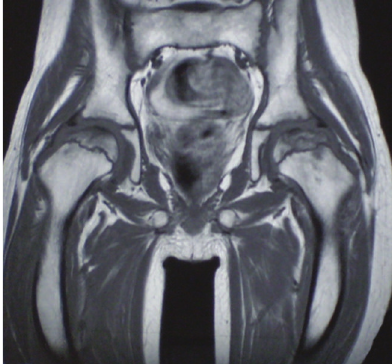
Figure 1: Moderate bilateral joint e ff usion and fat-like aspects of osteonecrosis involving the weight bearing portion of the femoral heads. In the left hip where the articular surface is partially flattened. Bone marrow oedema is also present bilaterally, around the femoral capital necrosis.